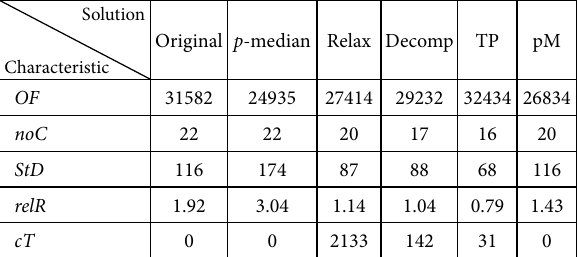
Table 4. Comparison of the results for the region TT